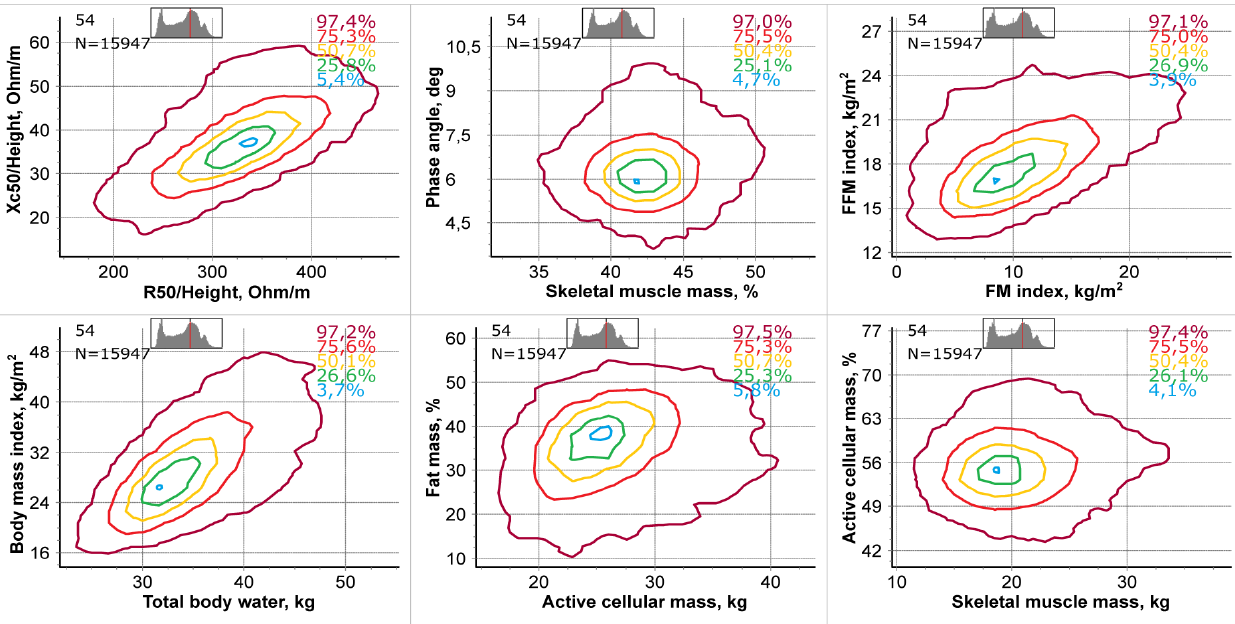
Fig. 4. An example of visualization of a bioimpedance study on 12 parameters, with centile lines arranged in two-dimensional graphs constructed from data of 15,947 women aged 54 full